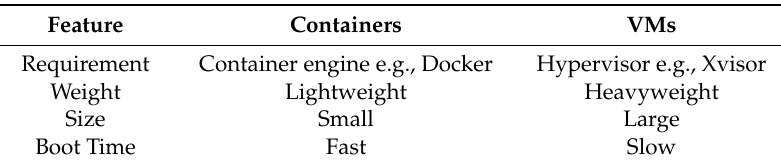
Table 1. Container-based vs. VM-based